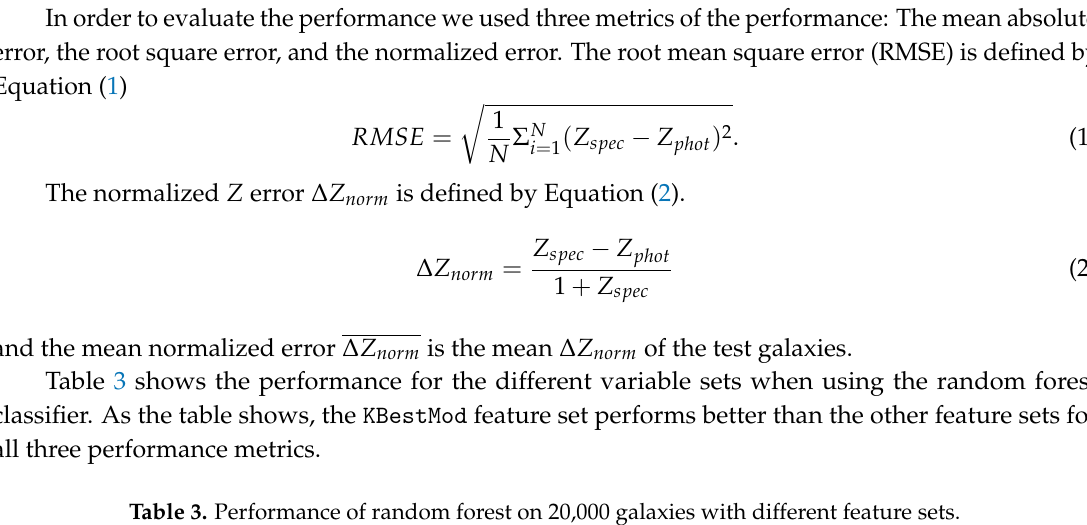
Table 3. Performance of random forest on 20,000 galaxies with different feature